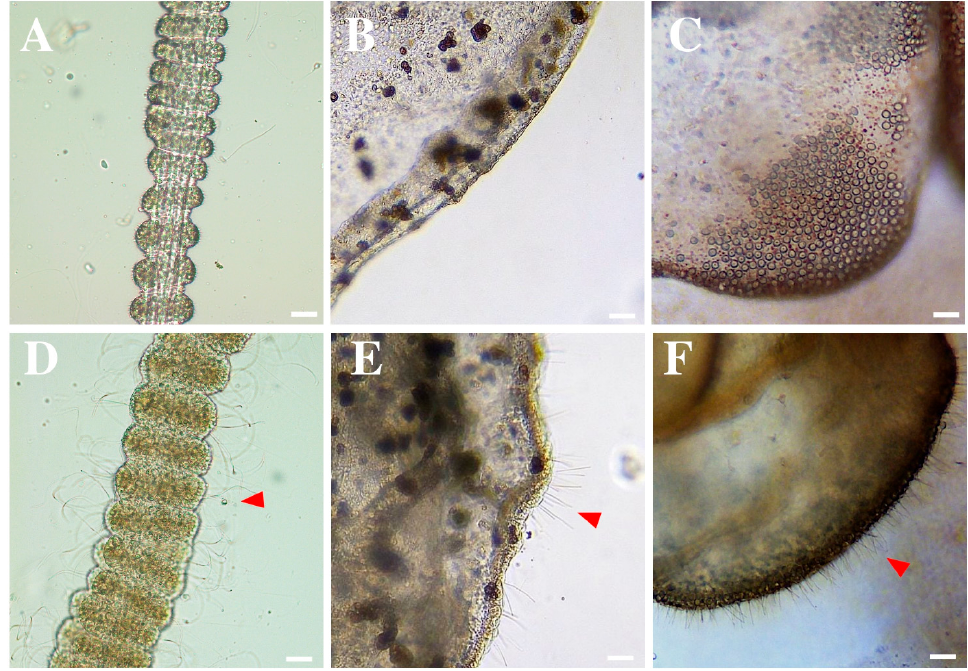
Figure 2. Nematocyst response in Aurelia sp. ( A , D ), Cassiopea sp. ( B , E ), and Rhizostoma luteum ( C , F ) after the application of ( A – C ) seawater (control) and ( D – F ) vinegar. Note the nematocyst discharge (red arrows) after vinegar application. Scale bars: 50 μ m. Table 2. Nematocyst response in scyphozoan jellyfish after the application of seawater (control) and vinegar. The number of replicates was ten for each rinse solution in Aurelia sp. and Cassiopea sp., and three in Rhizostoma luteum .